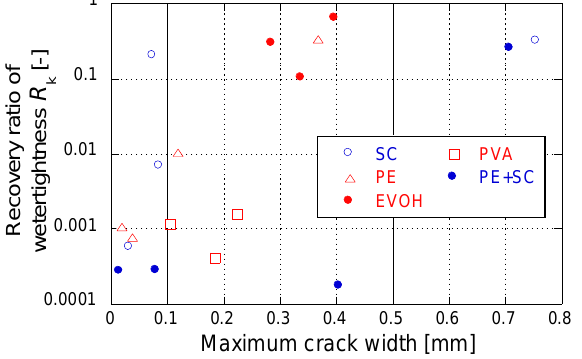
Figure 8. Relationship between the maximum crack width and recovery ratio of